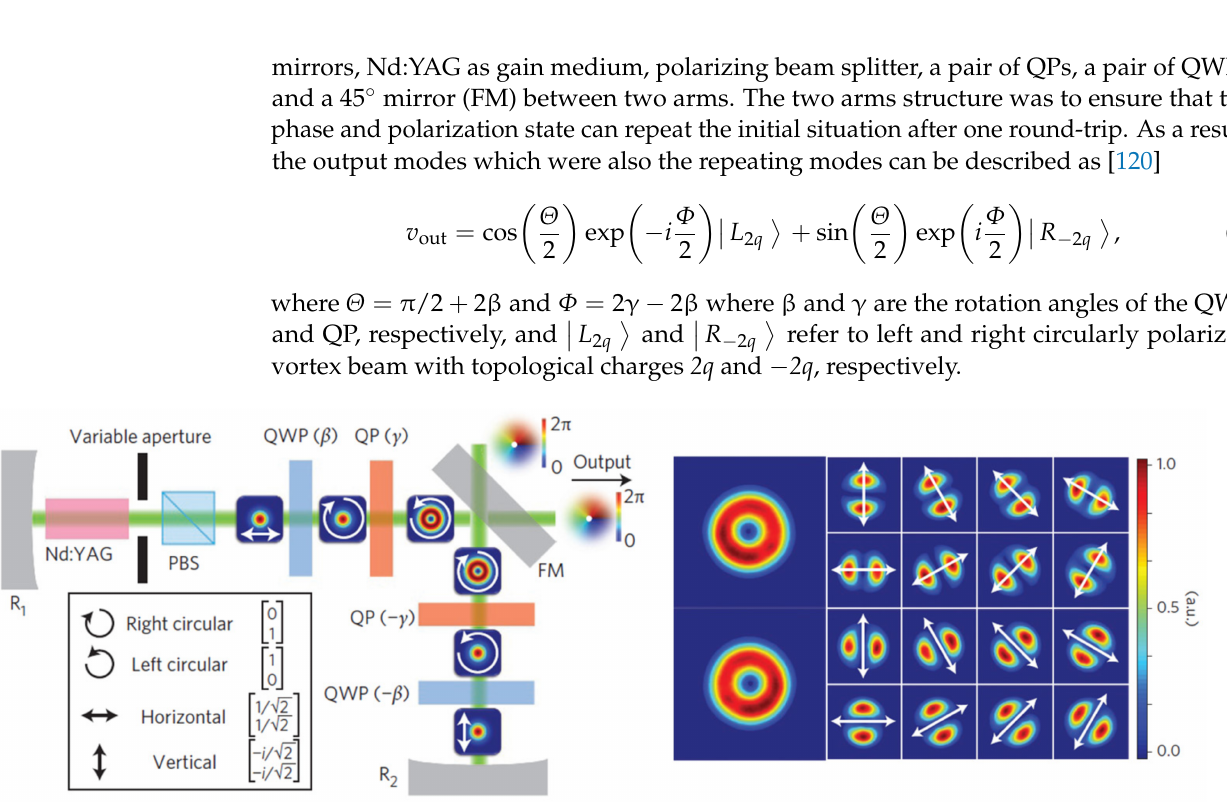
Figure 5. Generation of complex modes on HOP from a laser. Reprinted with permission from [120] © 2013 Macmillan Publishers